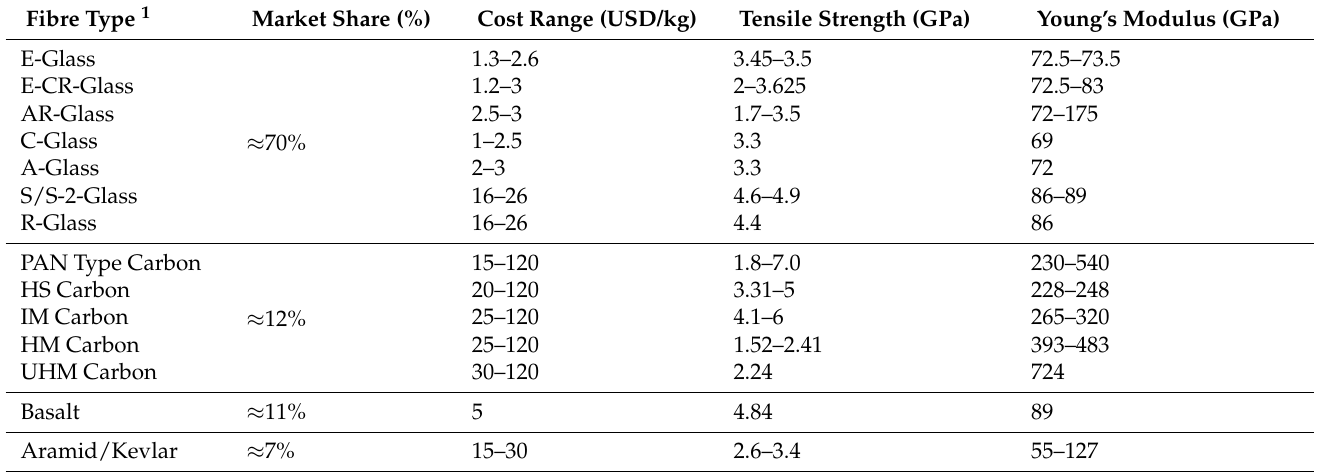
Table 1. Properties of several common synthetic fibres (reproduced from [13]).